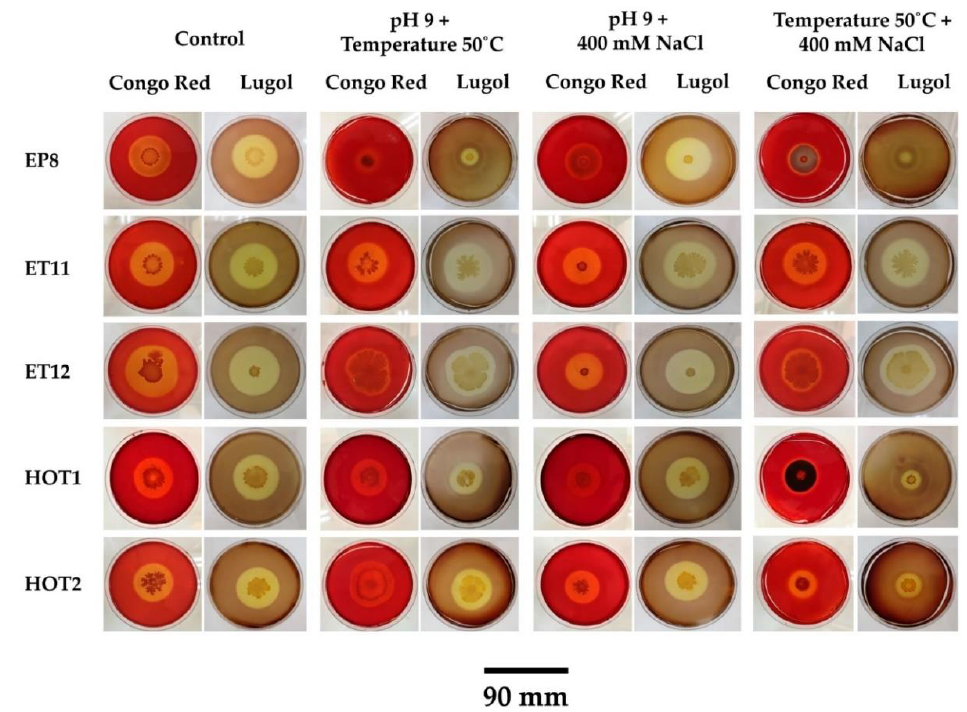
Figure 13. Illustration of the CMC hydrolysis zone by the strains tested in the presence of double stress revealed by Congo red and Lugol solutions.